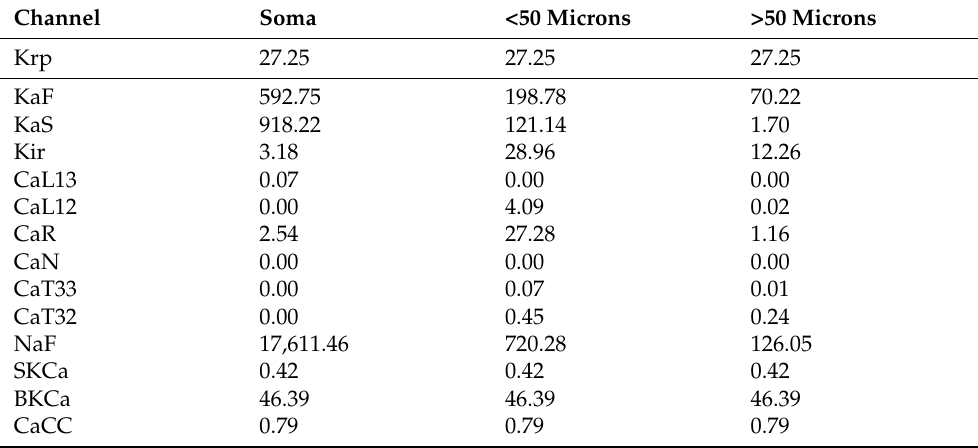
Table A1. Conductance values for ionic and synaptic channels in model in units of Siemens/meter